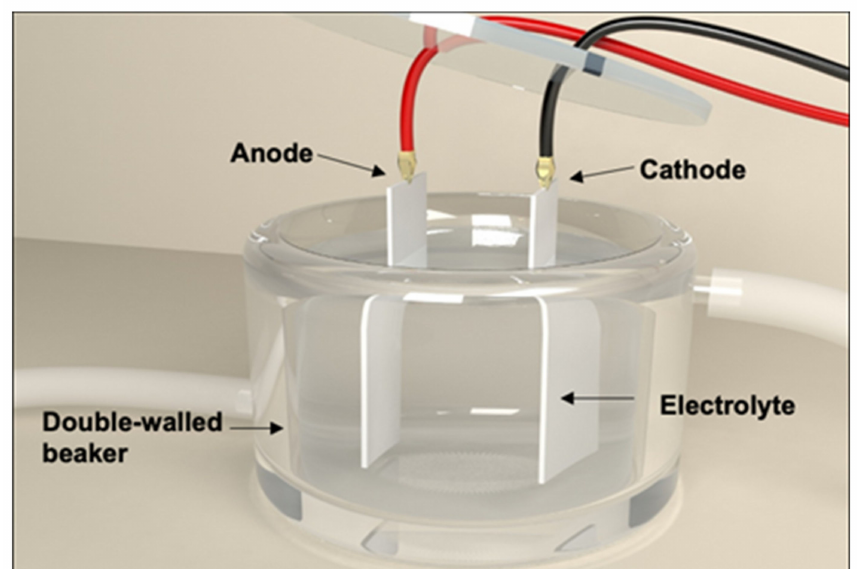
Figure 1. Schematic diagram of the fabrication system for the electrochemically etched stainless steel used in this study at the University of